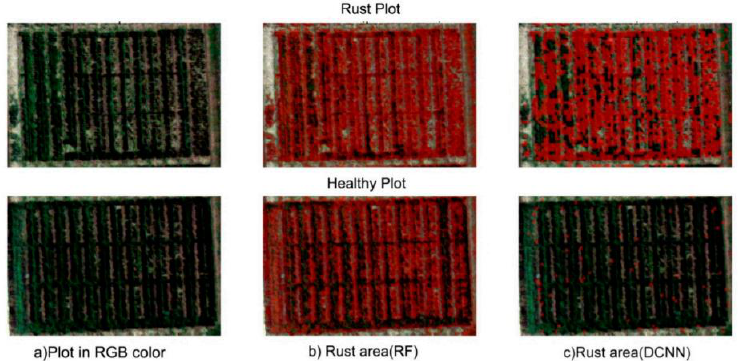
Figure 14. Hyperspectral images by UAV: ( a ) RGB color plots, ( b ) Random-Forest classifier, and ( c ) proposed multiple Inception-ResNet model [114] .